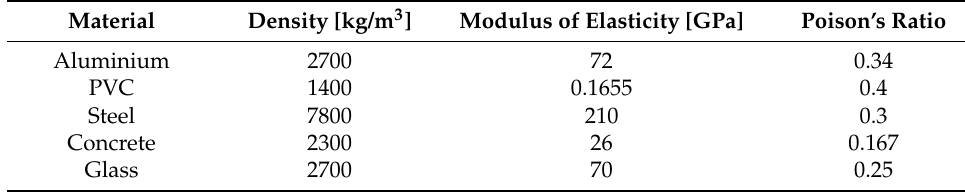
Table 7. Material properties used in the FE model.